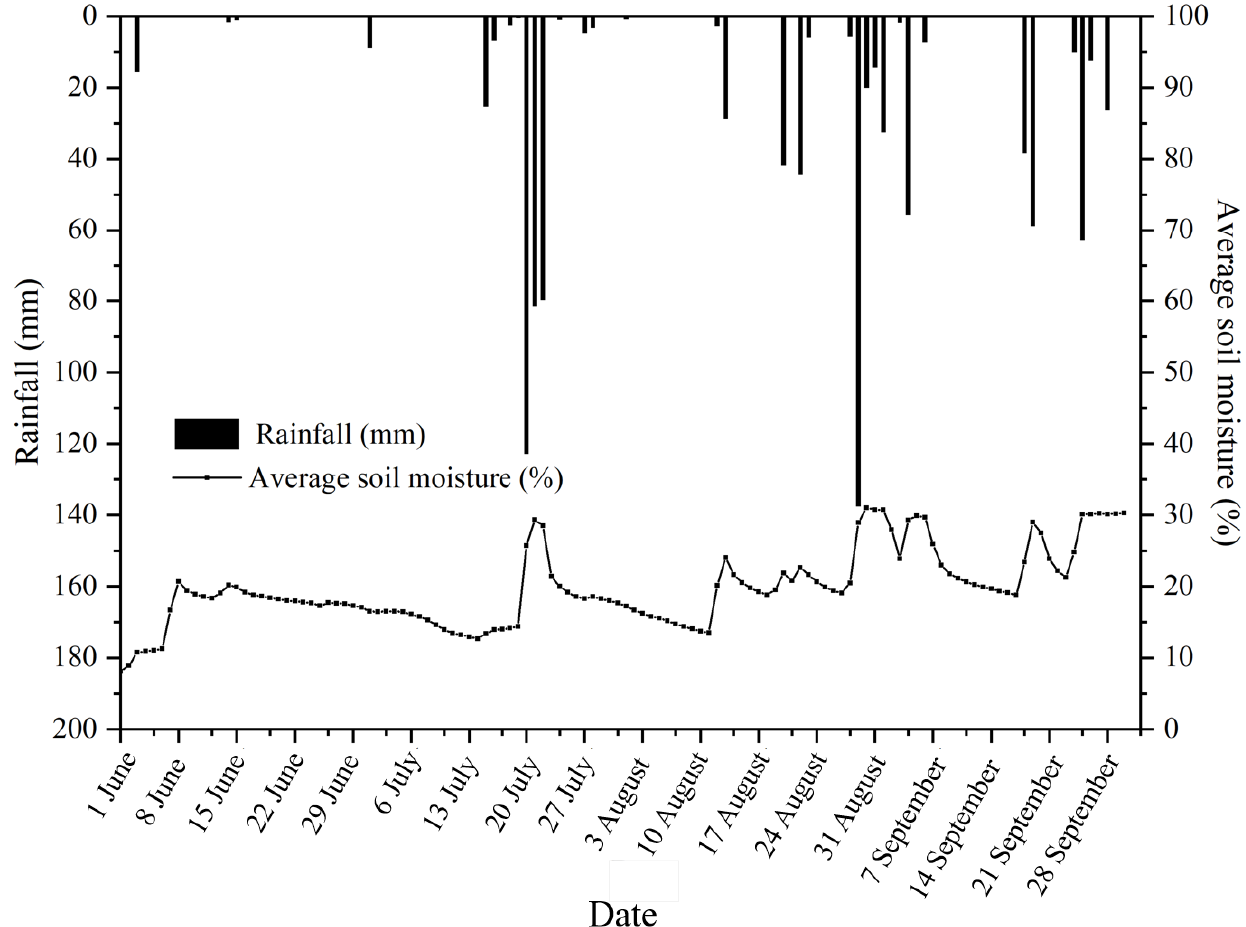
Figure 2. Daily rainfall events and soil moisture within the tillage layer in 2021.